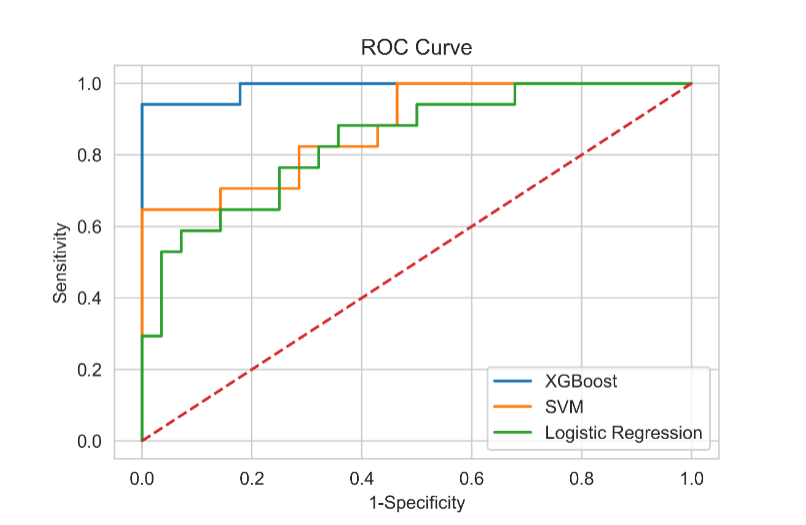
Figure 5. Roc curves among XGBoost, SVM and logistic